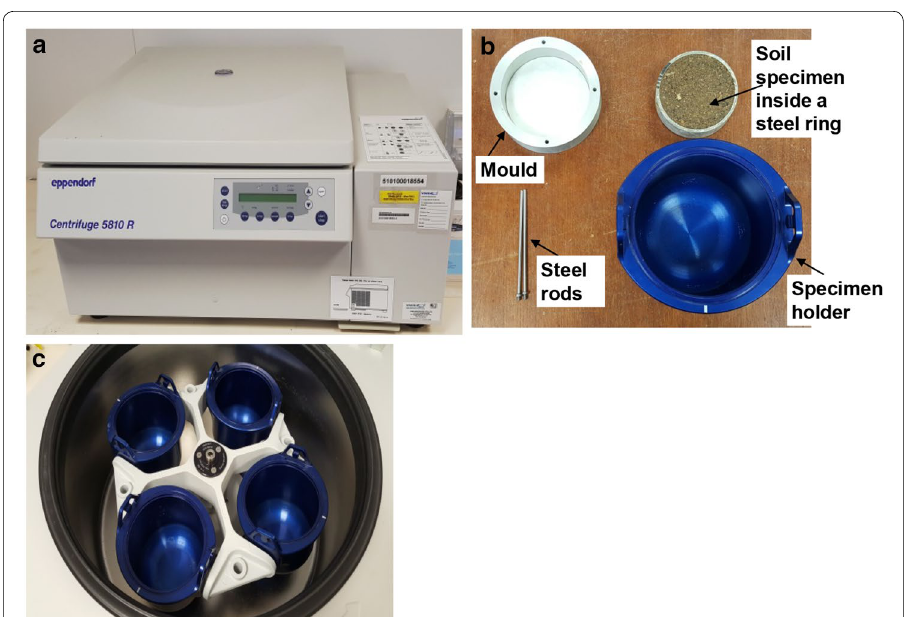
Fig. 4 a Front view, b the apparatus, c the specimen